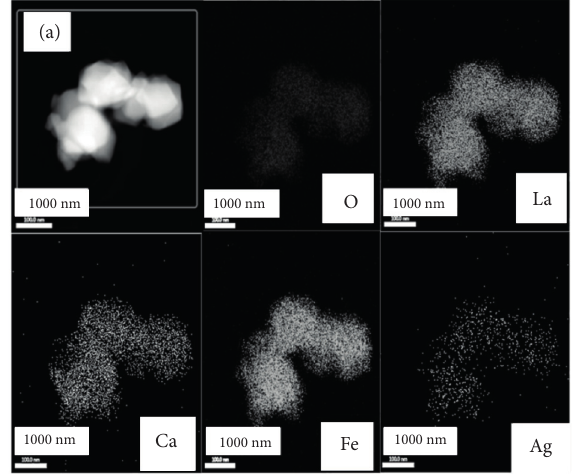
Figure 2: Network distance teaching based on streaming media technology has a wealth of